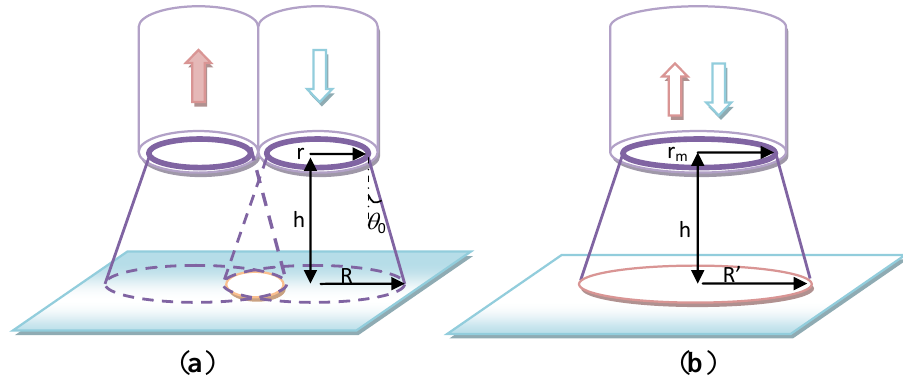
Figure 2. ( a ) Typical bifurcated optical fiber probe; ( b ) Single multi-mode fiber probe for enhanced light